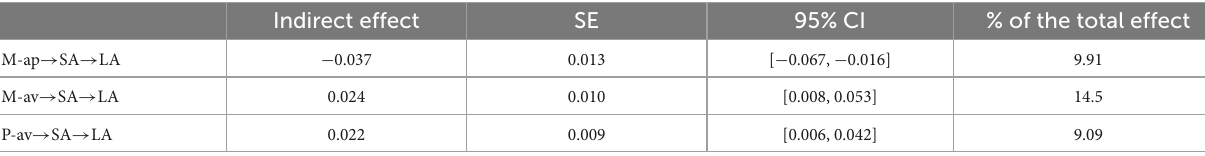
TABLE 2 The mediating effect of peer